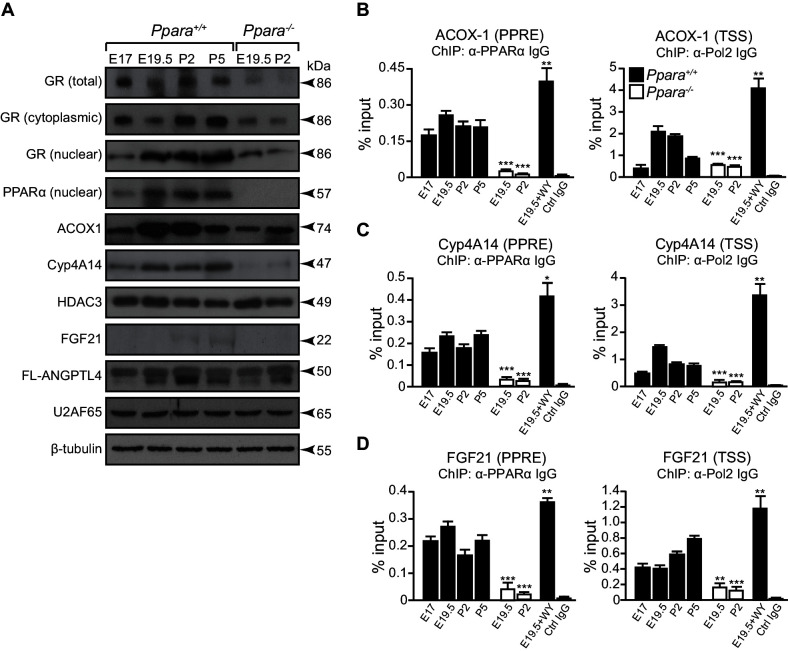
A temporal dichotomy in the regulation of PPARα target genes before and after birth.(A) Immunoblots showing the ontogenic expression of cytoplasmic and nuclear GR, HDAC3, PPARα, and its target genes, including ACOX1, Cyp4A14, FGF21, and full-length (FL)-ANGPTL4, in Ppara-/- and Ppara+/+ livers. U2AF65 and β-tubulin were used as loading controls for nuclear and cytoplasmic proteins, respectively. (B–D) Enrichment of the DNA fragment containing the PPAR response element (PPRE) (left panels) on the ACOX1 (B), Cyp4A14 (C), and FGF21 (D) promoters or their respective TSS (right panels) using anti-PPARα and anti-Pol2 antibodies or pre-immune IgG. Data are presented as mean ± SEM; n = 4–6, *p<0.05, **p<0.01, ***p<0.001 vs. untreated wild-type controls (two-tailed Mann-Whitney test).